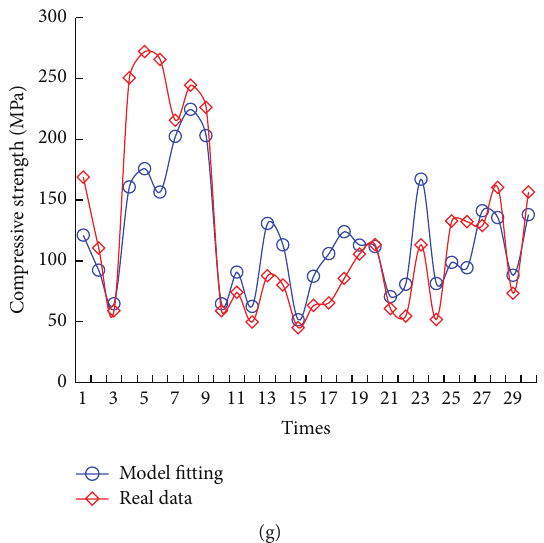
Figure 6: Multitraining results: (a) training on the first group of data; (b) training on the second group of data; (c) training on the third group of data; (d) training on the fourth group of data; (e) training on the fifth group of data; (f) training on the sixth group of data; (g) training on the seventh group of